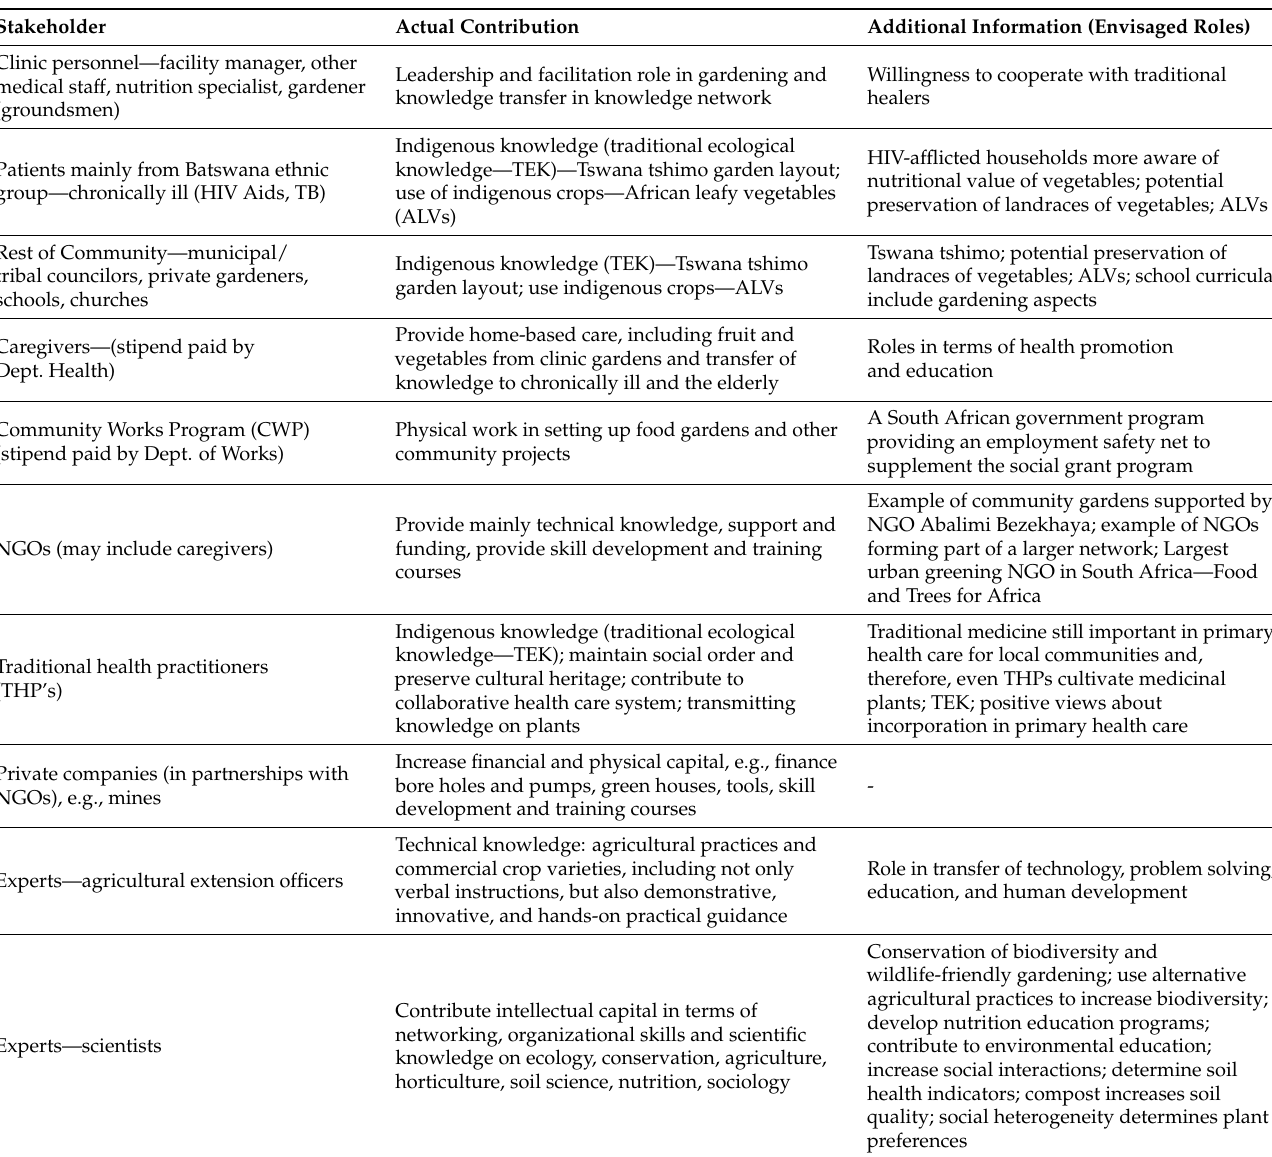
Table 1. Different types of stakeholders involved in health clinic gardens and classifications of their contribution in the gardens (Adapted from